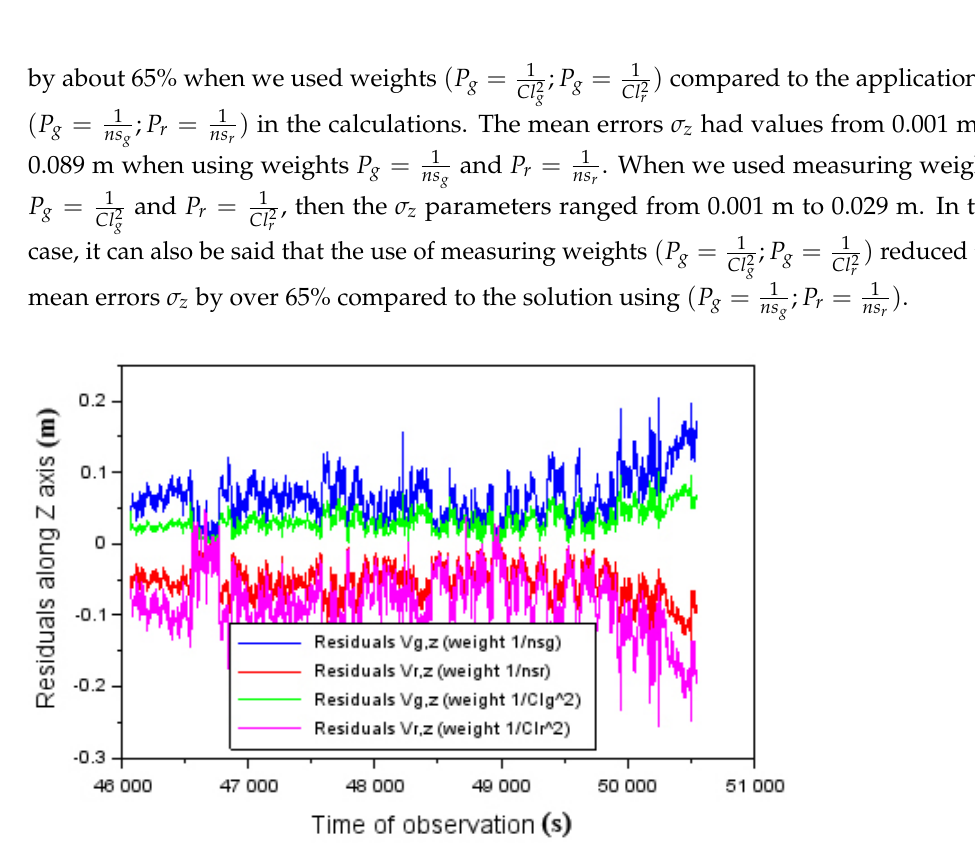
( ; ) V V along the Z -axis. Figure 7. Residuals ( V g , z ; V r , z ) along the Z -axis. , , g z r z